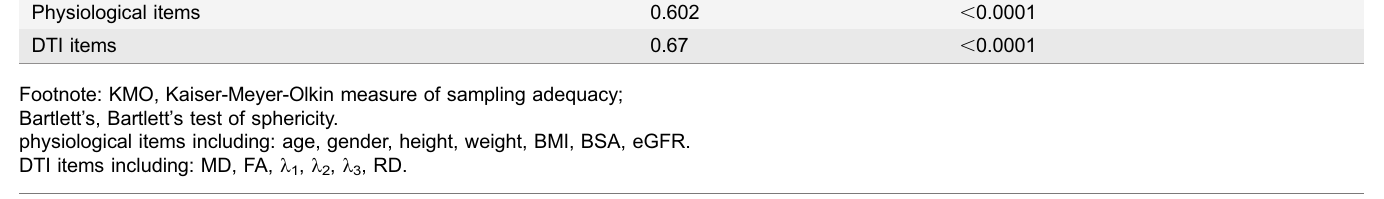
Figure 2. Cortical and medullary DTI parameters by kidney and gender. (A) Comparison of cortical and medullary FA values by kidney and gender; (B) Comparison of medullary RD values by kidney and gender; (C) Comparison of cortical and medullary l values by kidney and gender.